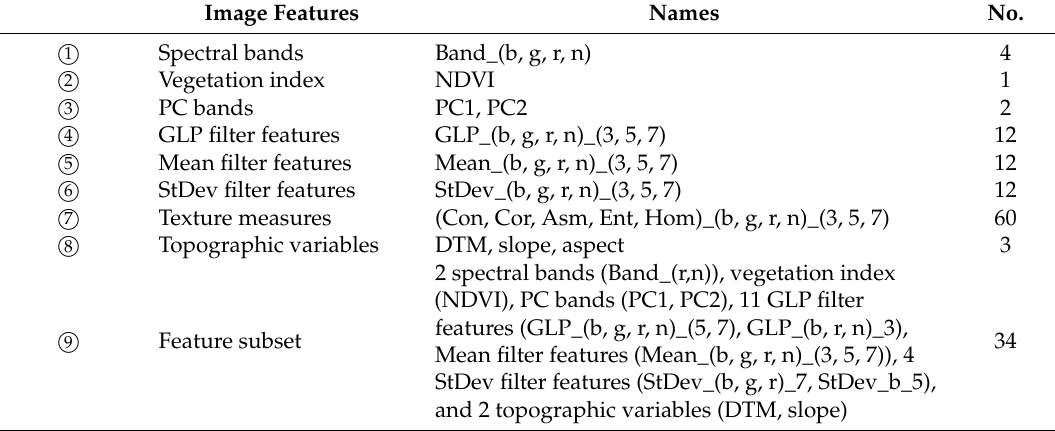
Table 1. Image feature sets used in this study (revised from [14]). Band (b, g, r, n): the blue, green, red, and near-infrared bands; NDVI: the normalized difference vegetation index; PC: principal